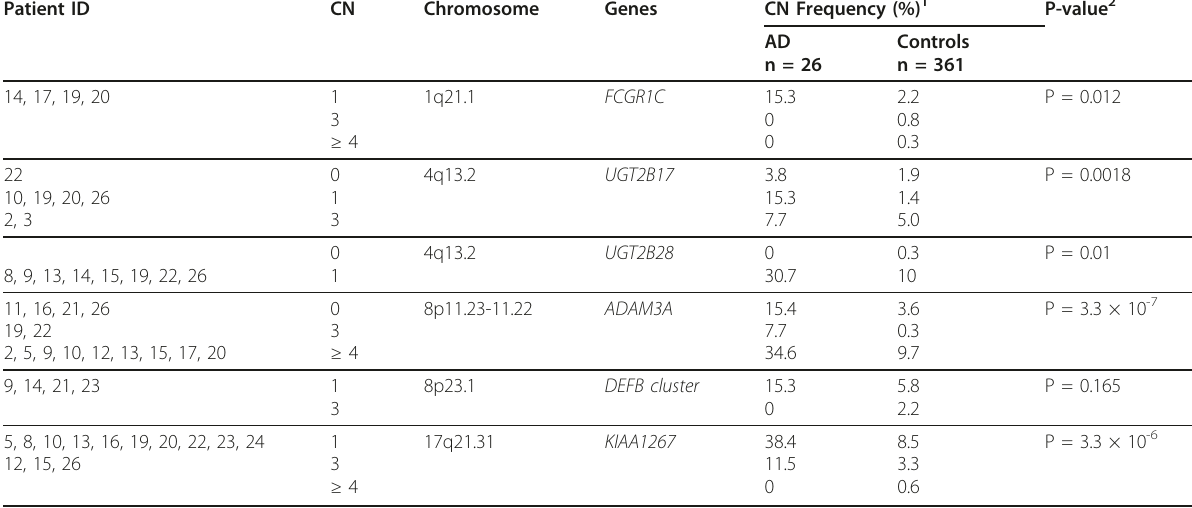
Table 1 Gene regions ( ≥ 100 Kbp) of the most frequent copy number (CN) variation in patients with Addison ’ s disease detected by gene chip Patient ID